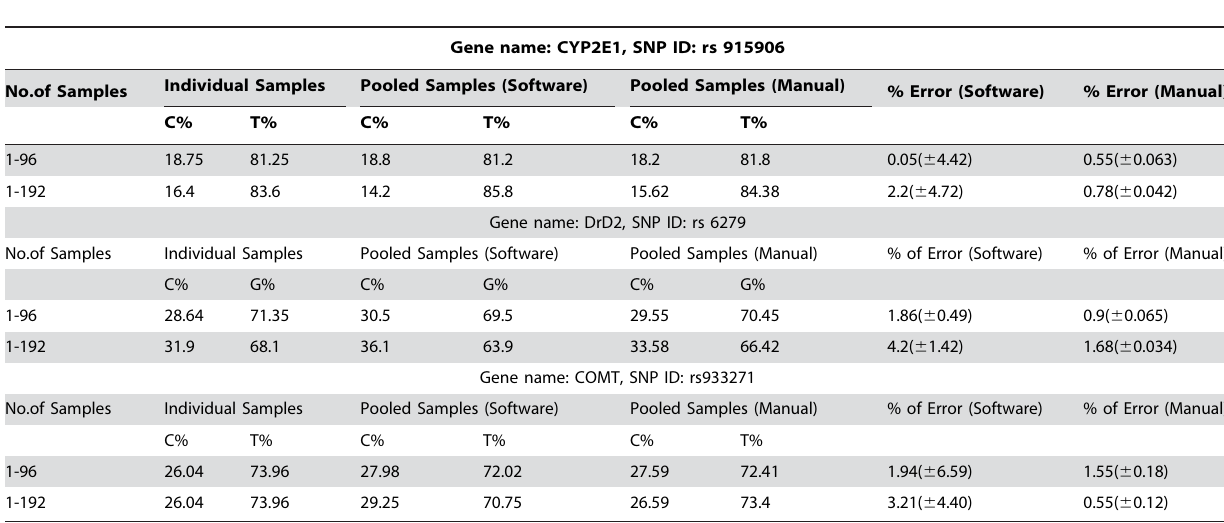
Table 1. Comparison of allele frequency of three SNPs from a pool of 192 controls using manual and software